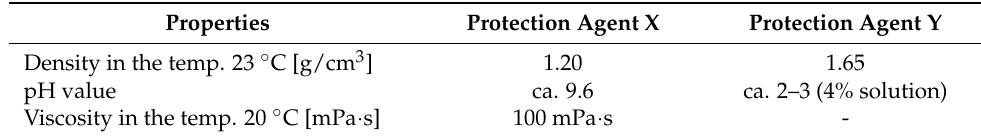
Table 1. Basic properties of protection agents used for